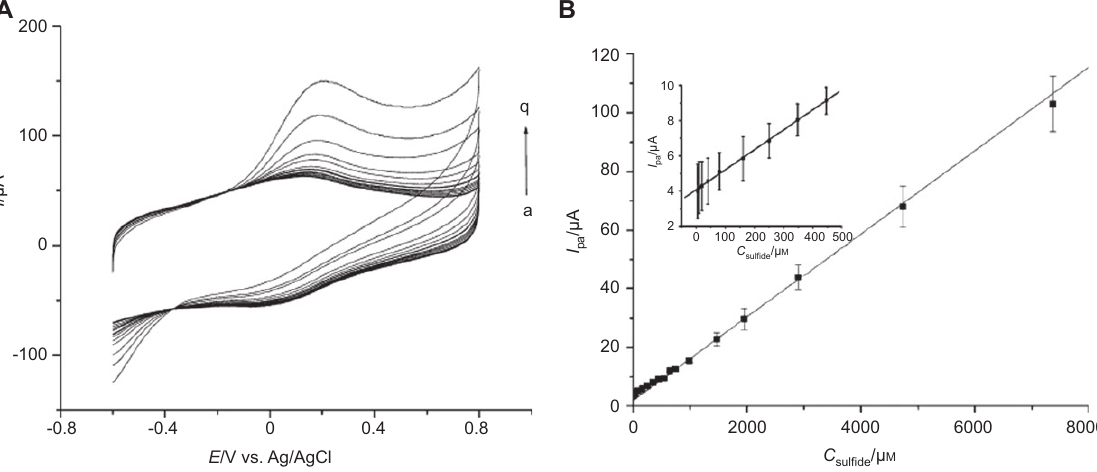
Figure 4 (A) Cyclic voltammograms of reduced graphene sheets (RGSs)/glassy carbon (GC) electrode in 0.2 m PBS (pH 7.4) containing dif- ferent concentrations of sulfide of (a) 5 × 10 -3 , (b) 1.0 × 10 -2 , (c) 2.0 × 10 -2 , (d) 4.0 × 10 -2 , (e) 8.0 × 10 -2 , (f) 0.16, (g) 0.25, (h) 0.35, (i) 0.45, (j) 0.54, (k) 0.74, (l) 0.98, (m) 1.47, (n) 1.95, (o) 2.9, (p) 4.7, and (q) 7.4 m m ; and (B) the changes of I versus concentrations of sulfide ranging from pa versus concentration of sulfide ranging from 5 × 10 -3 to 0.45 m m 5 × 10 -3 to 7.4 m m . Inset: Plot of changes of I pa